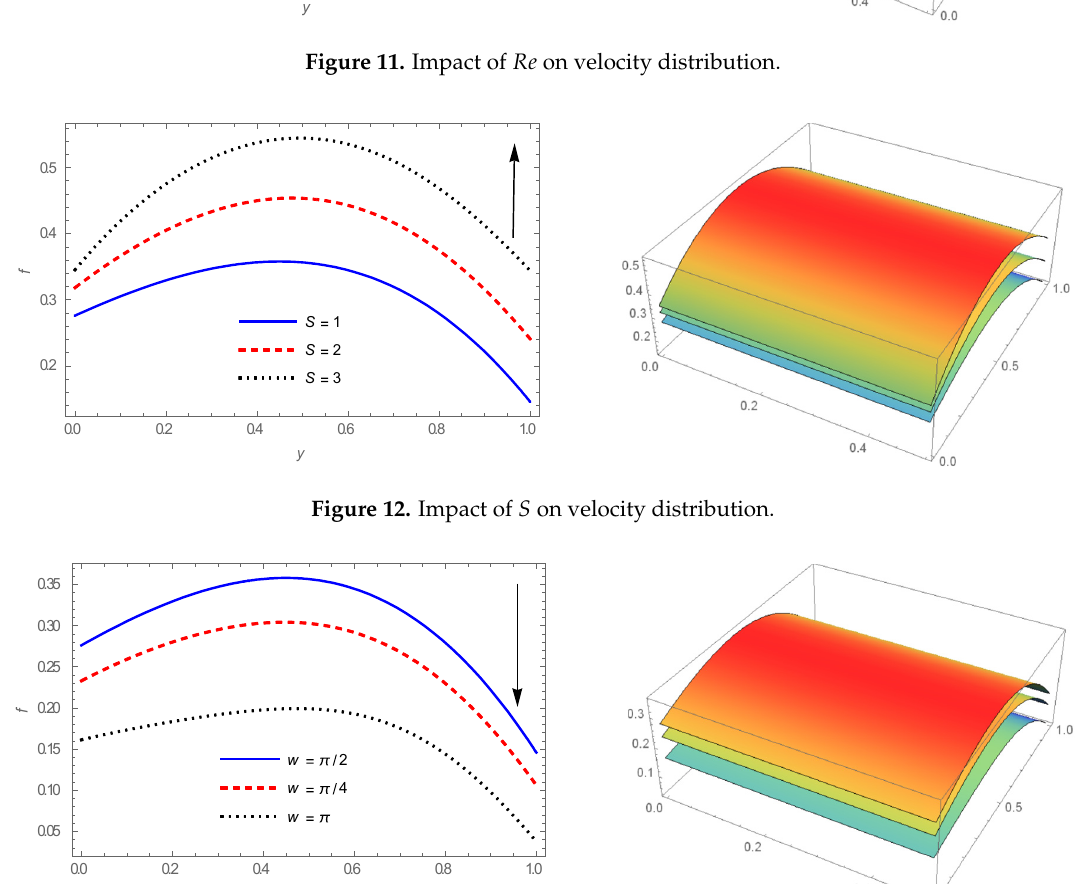
Figure 13. Impact of (cid:2033) on velocity distribution.